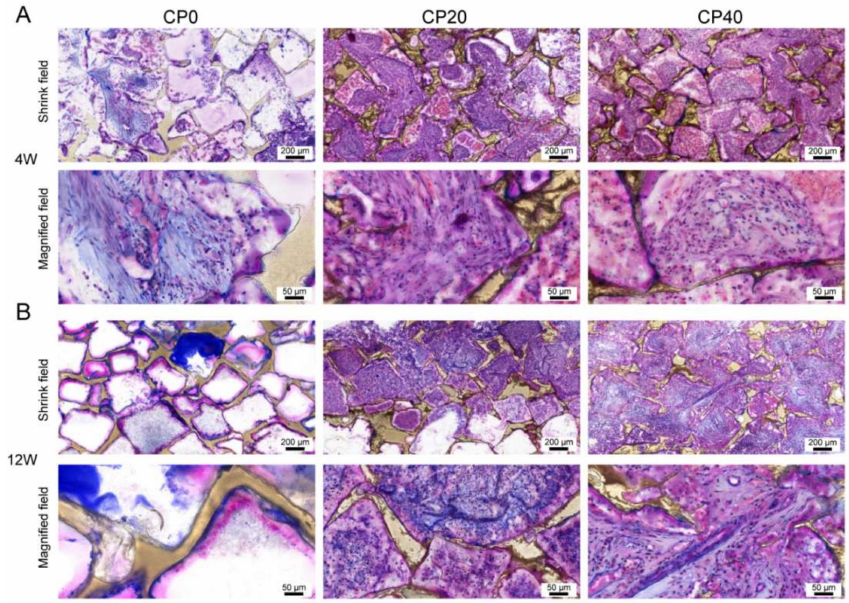
Figure 9. Masson staining of implant scaffolds at 4 weeks ( A ) and 12 weeks ( B ). The blue area represents collagen fiber, and the distribution of collagen fiber in Groups B and C was more extensive.